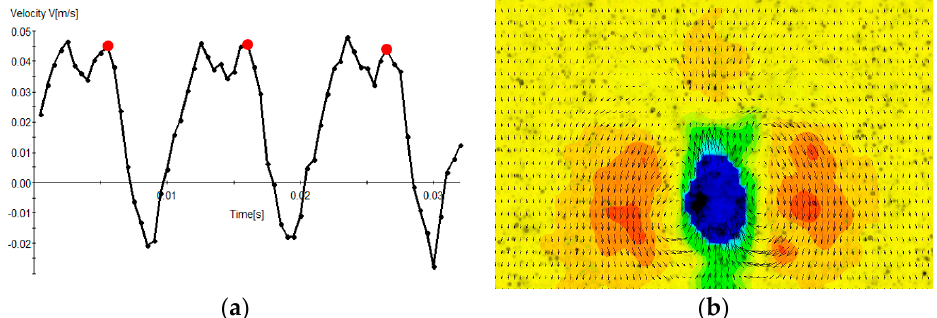
Figure 16. ( a ) Tonsa ’s swim speed. ( b ) Phase-lock averaged flow field during 2nd power stroke.